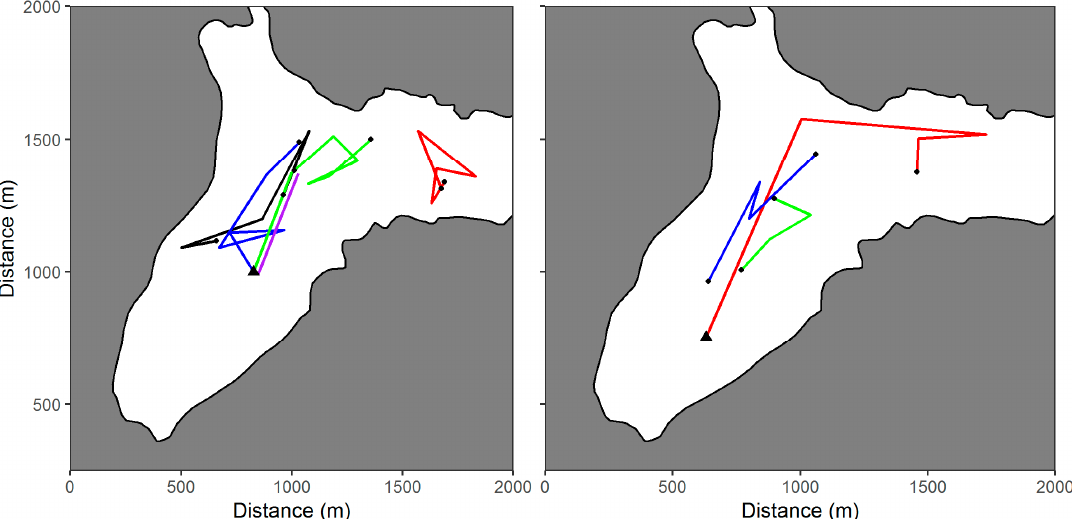
Figure 4. Movements of juvenile Chinook salmon tagged with acoustic transmitters and located using an autonomous underwater vehicle in Big Port Walter, Alaska. The movements of five fish detected during Mission 24 are shown in the left panel. The right panel shows the movements of Fish 12003 over three successive missions. The site where the fish were initially released (black triangle) and the last location of the fish (black dot) are indicated.